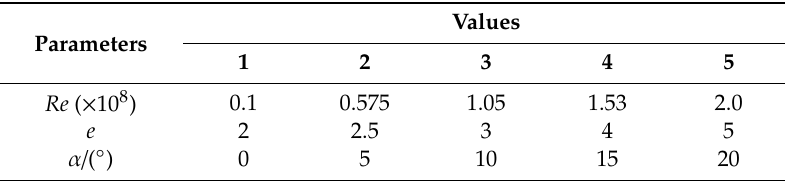
Table 2. Values of di ff erent parameters.